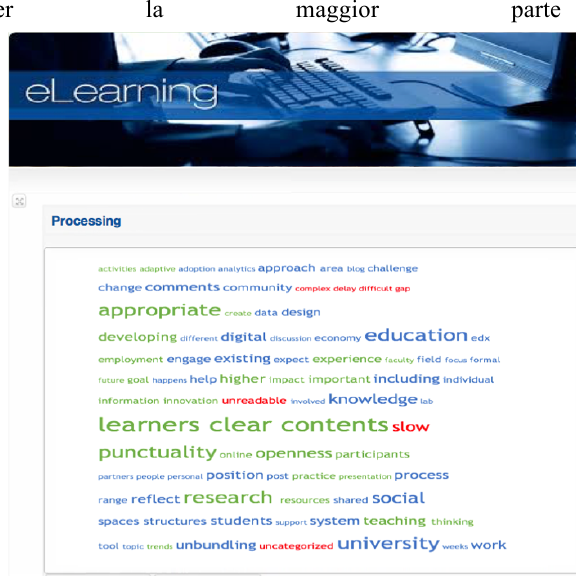
Figure 3: e-learning project tag cloud within the tool’s web